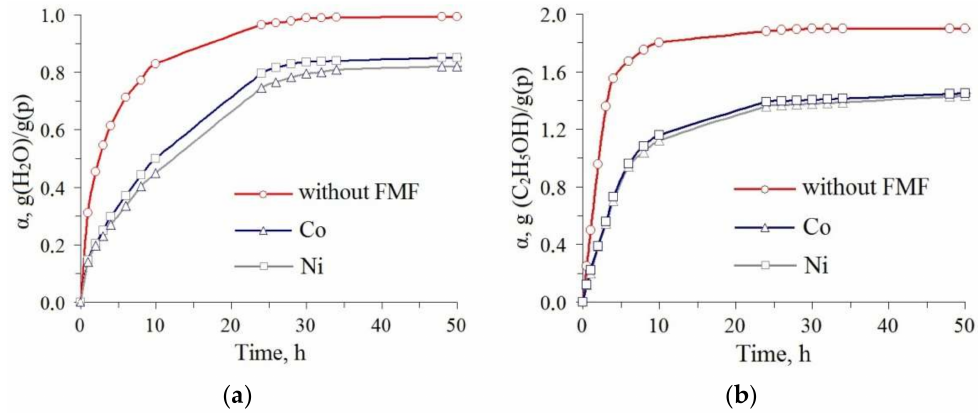
Figure 7. The effect of the presence of FMF in the structure of pHEMA-gr-PVP copolymers on their swelling ability (HEMA:PVP = 80:20 mass parts, [FMF] = 10 wt.%): ( a ) in water; ( b ) in